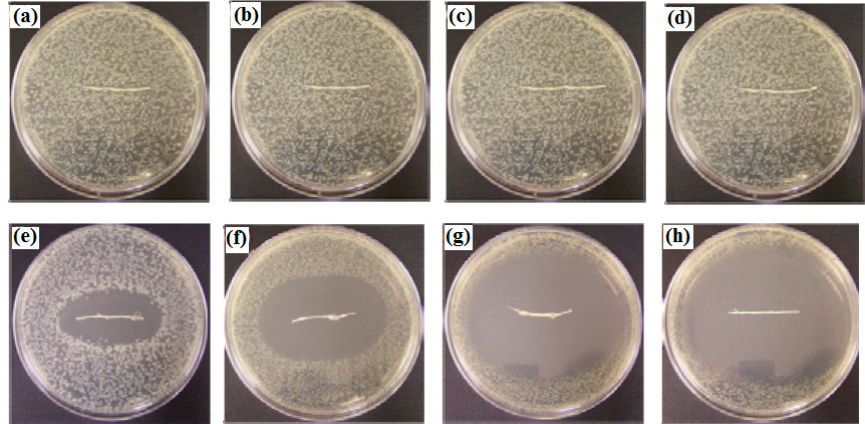
Figure 6. Clear inhibition zone diameter of electrospun PCL/MAA copolymer nanofibers without AgNPs against ( a ) Escherichia coli ; ( b ) Pseudomonas aeruginosa ; ( c ) Bacillus